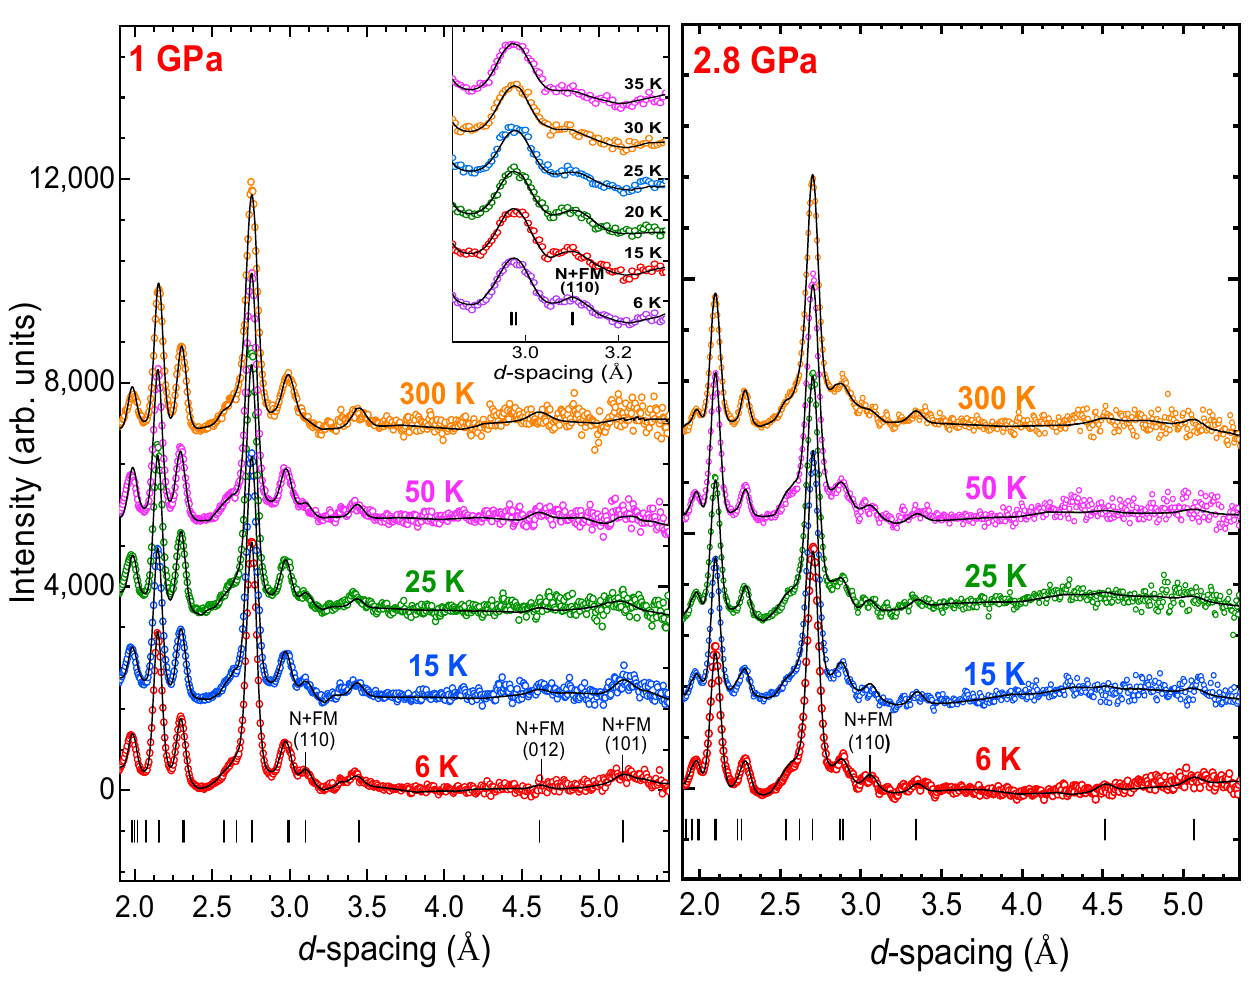
Figure 2. Neutron diffraction patterns of CrBr 3 measured at selected pressures and temperatures and refined by the Rietveld method. The experimental points and calculated profiles are shown. Ticks below represent calculated positions of the nuclear peaks of the rhombohedral phase of CrBr 3 . The magnetic contribution into nuclear peaks is labeled as “N+FM”. Inset: the pressure evolution of the characteristic peak with additional magnetic contribution.